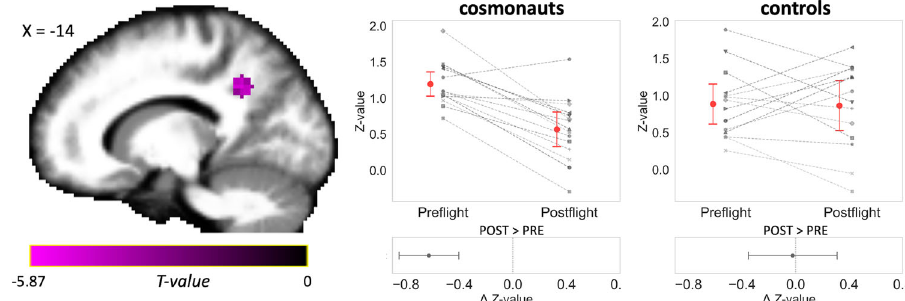
Fig. 1 Connectivity of the posterior cingulate cortex with the rest of the brain is reduced after space fl ight. At post fl ight, cosmonauts exhibited decreased participation of the posterior cingulate cortex (PCC) in whole-brain connectivity when compared to the pre fl ight scan. Individual intrinsic connectivity contrast (ICC) values (gray) as extracted from the PCC cluster across the two scans in the cosmonaut group con fi rmed this decreasing effect for most cosmonauts (red: mean). For comparative purposes, in the control group ( n = 14) ICC values did not show signi fi cant modi fi cations across time (average change approximated zero). Subplots summarize the estimated differences between the two timepoints. Error bars indicate 95% con fi dence intervals. Slice coordinates are in MNI space. Statistical signi fi cance is based on p < 0.005 uncorrected at the voxel level followed by p < 0.05 corrected for family-wise error at the cluster level ( n =